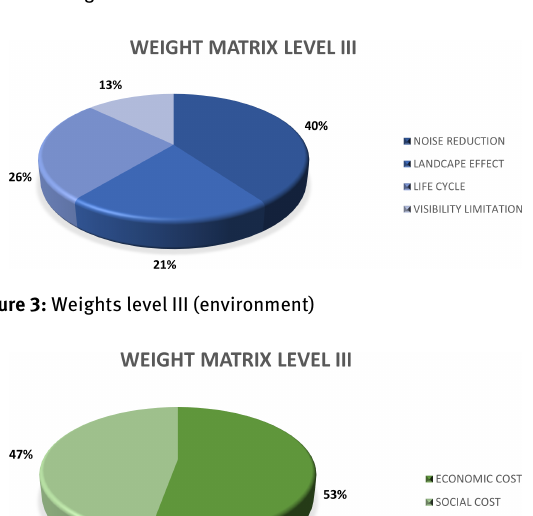
Figure 2: Weights level II